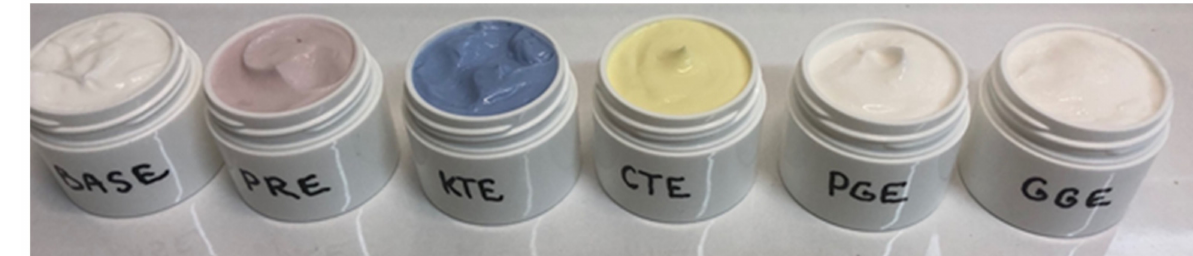
Figure 10. Photo of model face skin care creams containing water–ethanol extracts: P. rhoeas L. (PRE), P. granatum L. (PGE) , C. ternatea L. (KTE), C. tinctorius L. (CTE) , G. globasa L.